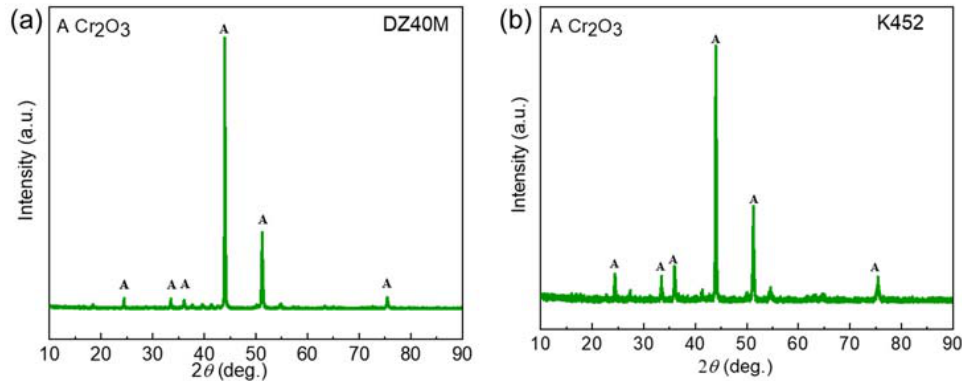
Figure 5. XRD of 100 h oxidation product of DZ40M ( a ), and K452 ( b ).